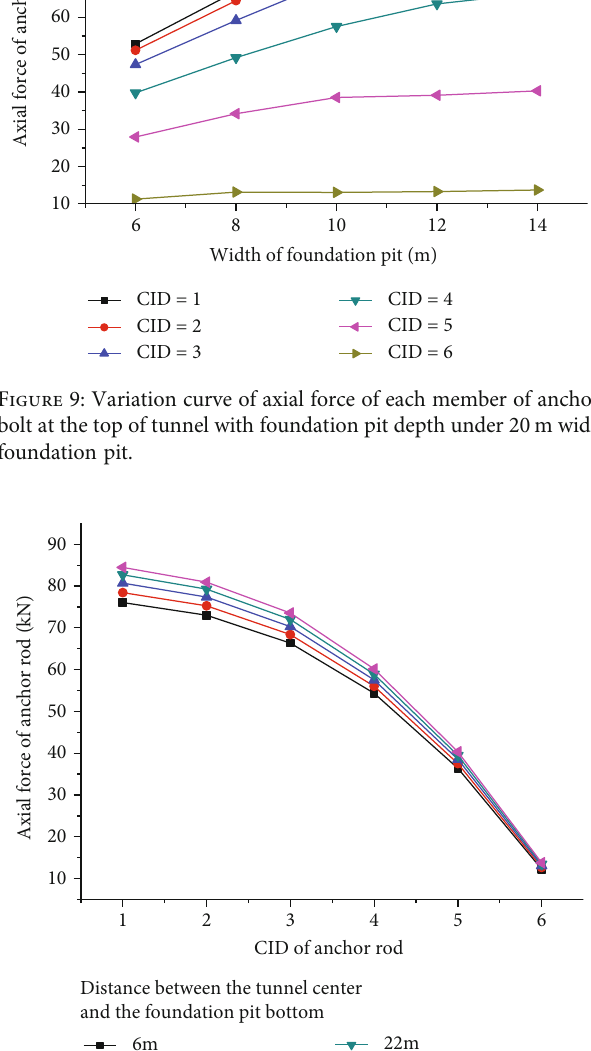
Figure 8: Axial force of anchor rod at the top of tunnel 6 m beneath a 20m wide pit with di ff erent depths.